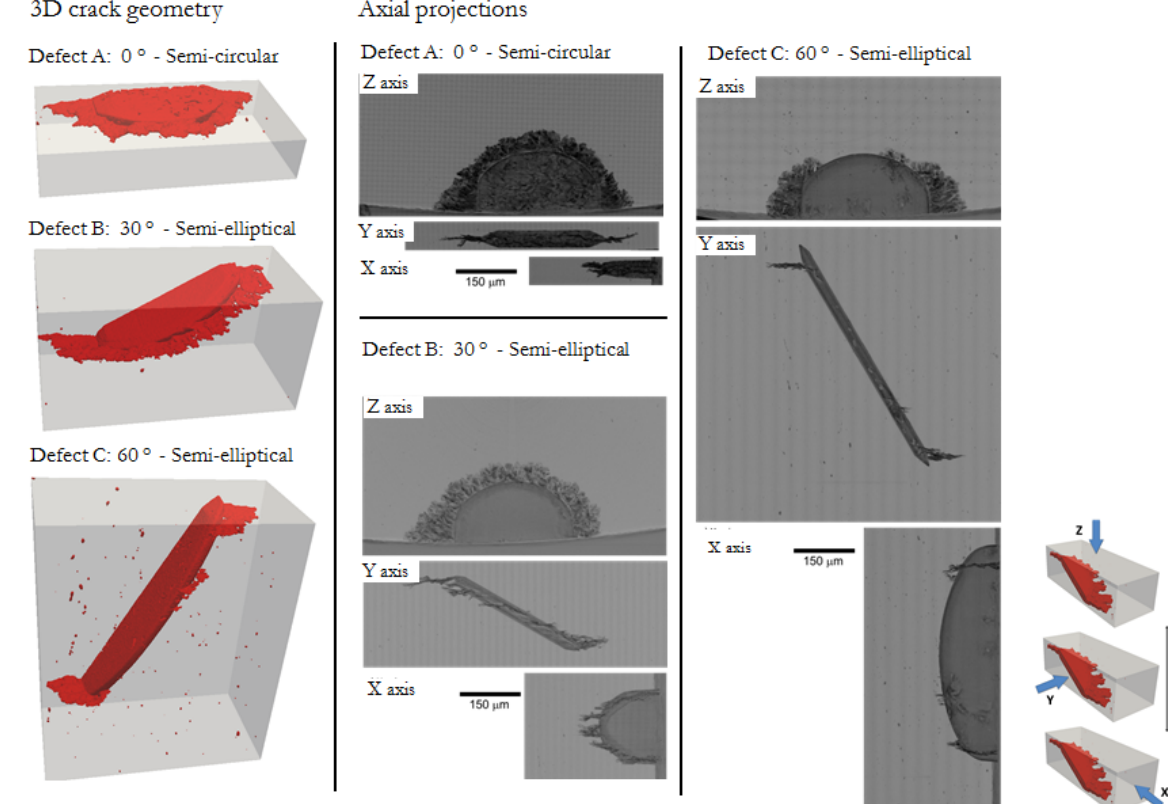
Figure 3: Left: 3D images of non-propagating cracks found at the fatigue limit. Right: Crack projections in to Z, Y and X axis (minimum intensity). Material: Annealed JIS-S45C steel.